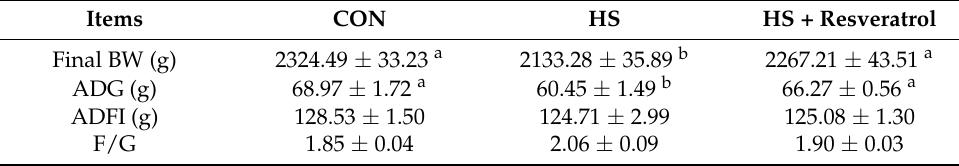
Table 3. Effect of resveratrol on the growth performance of broilers under